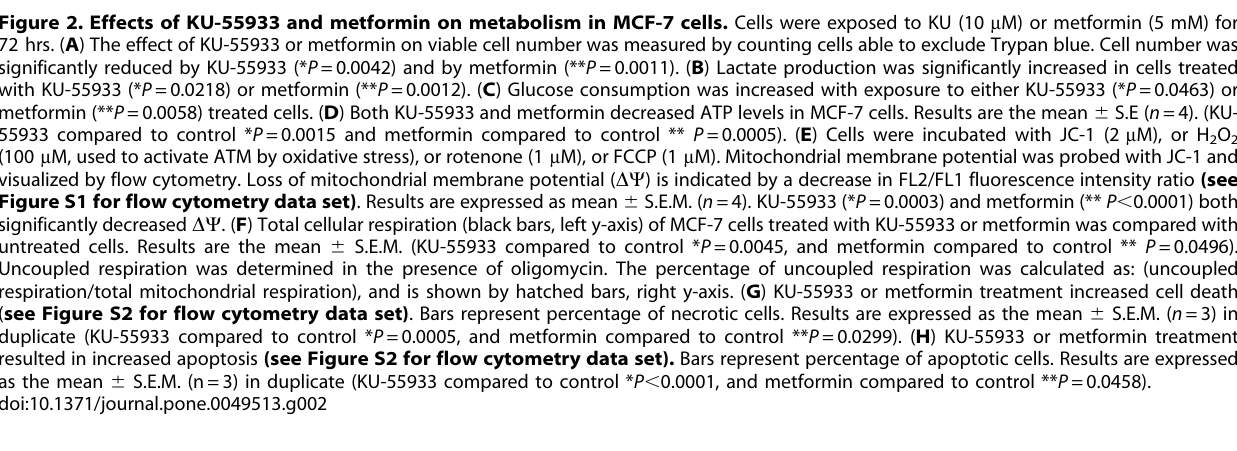
Figure 2. Effects of KU-55933 and metformin on metabolism in MCF-7 cells. Cells were exposed to KU (10 m M) or metformin (5 mM) for 72 hrs. ( A ) The effect of KU-55933 or metformin on viable cell number was measured by counting cells able to exclude Trypan blue. Cell number was significantly reduced by KU-55933 (* P =0.0042) and by metformin (** P =0.0011). ( B ) Lactate production was significantly increased in cells treated with KU-55933 (* P =0.0218) or metformin (** P =0.0012). ( C ) Glucose consumption was increased with exposure to either KU-55933 (* P =0.0463) or metformin (** P =0.0058) treated cells. ( D ) Both KU-55933 and metformin decreased ATP levels in MCF-7 cells. Results are the mean 6 S.E ( n =4). (KU- 55933 compared to control * P =0.0015 and metformin compared to control ** P =0.0005). ( E ) Cells were incubated with JC-1 (2 m M), or H 2 O 2 (100 m M, used to activate ATM by oxidative stress), or rotenone (1 m M), or FCCP (1 m M). Mitochondrial membrane potential was probed with JC-1 and visualized by flow cytometry. Loss of mitochondrial membrane potential ( DY ) is indicated by a decrease in FL2/FL1 fluorescence intensity ratio (see Figure S1 for flow cytometry data set) . Results are expressed as mean 6 S.E.M. ( n =4). KU-55933 (* P =0.0003) and metformin (** P , 0.0001) both significantly decreased DY . ( F ) Total cellular respiration (black bars, left y-axis) of MCF-7 cells treated with KU-55933 or metformin was compared with untreated cells. Results are the mean 6 S.E.M. (KU-55933 compared to control * P =0.0045, and metformin compared to control ** P =0.0496). Uncoupled respiration was determined in the presence of oligomycin. The percentage of uncoupled respiration was calculated as: (uncoupled respiration/total mitochondrial respiration), and is shown by hatched bars, right y-axis. ( G ) KU-55933 or metformin treatment increased cell death ( see Figure S2 for flow cytometry data set) . Bars represent percentage of necrotic cells. Results are expressed as the mean 6 S.E.M. ( n =3) in duplicate (KU-55933 compared to control * P =0.0005, and metformin compared to control ** P =0.0299). ( H ) KU-55933 or metformin treatment resulted in increased apoptosis (see Figure S2 for flow cytometry data set). Bars represent percentage of apoptotic cells. Results are expressed